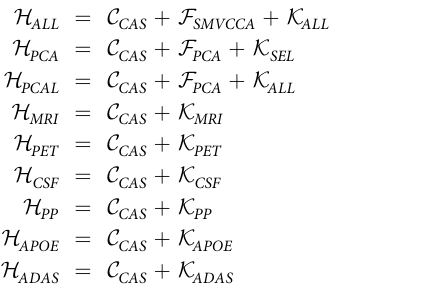
Experiment 2: Comparison of Multi-Class Classification Strategies for Fused Predictors. The